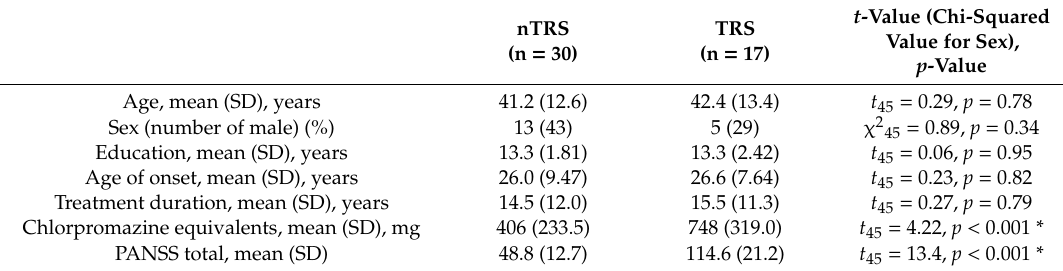
Table 1. Clinico-demographics